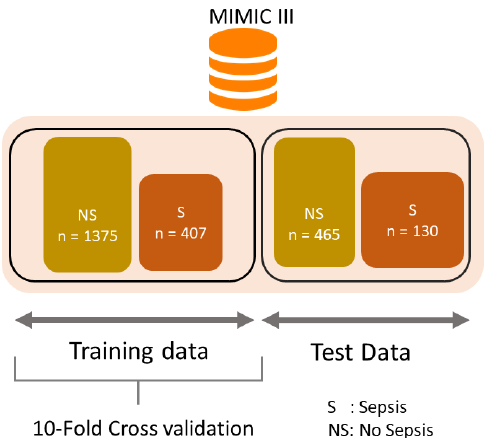
Figure 9. Detailed information about the training and test sets data samples.